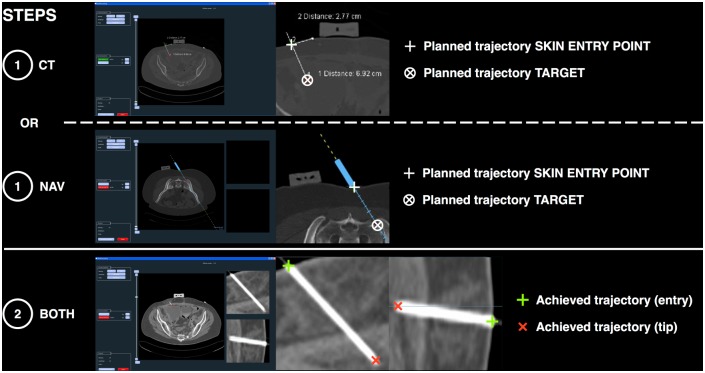
Examples of image data processing during main outcome computation.Distance and angle measurements are performed in two steps using a dedicated software: 1: The planned trajectory (i.e. planned entry point and planned target) is extracted from images saved by the operator before the needle is placed, showing the chosen trajectory that the operator will try to reproduce when placing the needle. The operator saves the planned trajectory either on the CT console (CT group) or on the navigation system (NAV group). 2: Once the needle has been positioned, the achieved trajectory is extracted from the first control CT acquisition showing the actual position of the needle. Multiplanar image reconstructions allow a fine selection of the points that define the entry point and the tip of the needle. The distance and angle between the planned and achieved trajectories (cf. Fig 2) are then computed using the software and saved for statistical analysis.